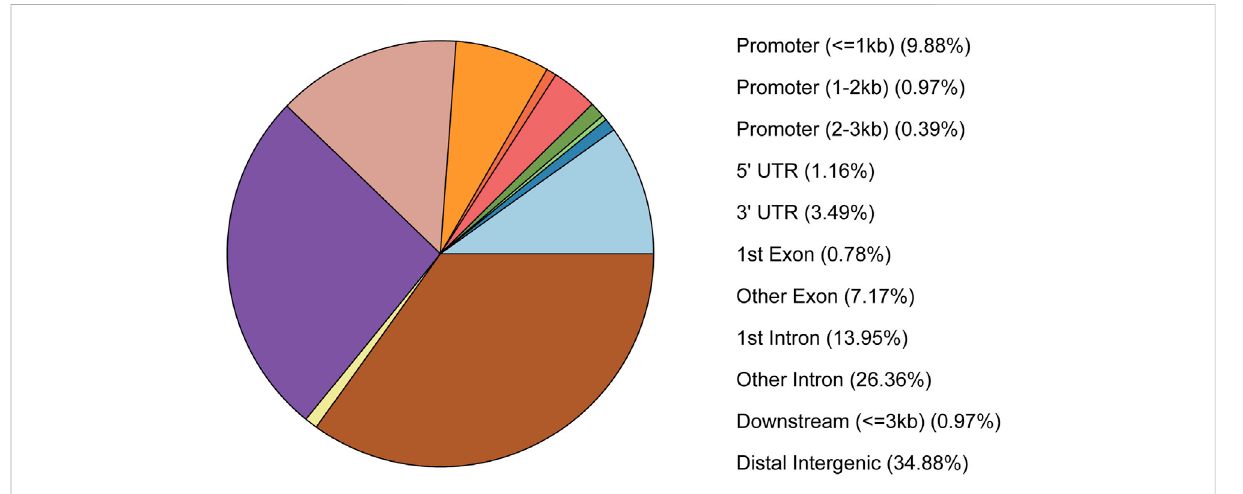
FIGURE 2 The pie chart of peaks annotated into the genomic